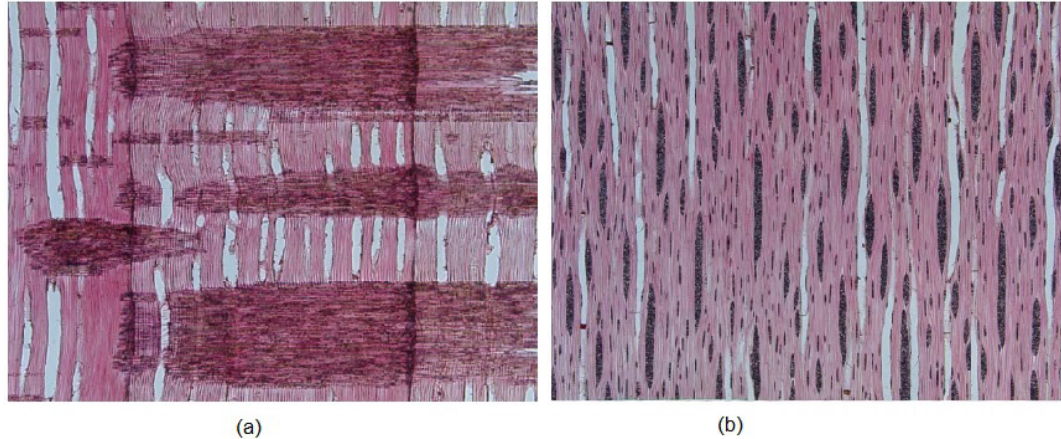
Figure 22. The amount of medullary rays on the radial-longitudinal (a) and tangential-longitudinal (b) planes of Sugar Maple wood species. (Images courtesy of Alex